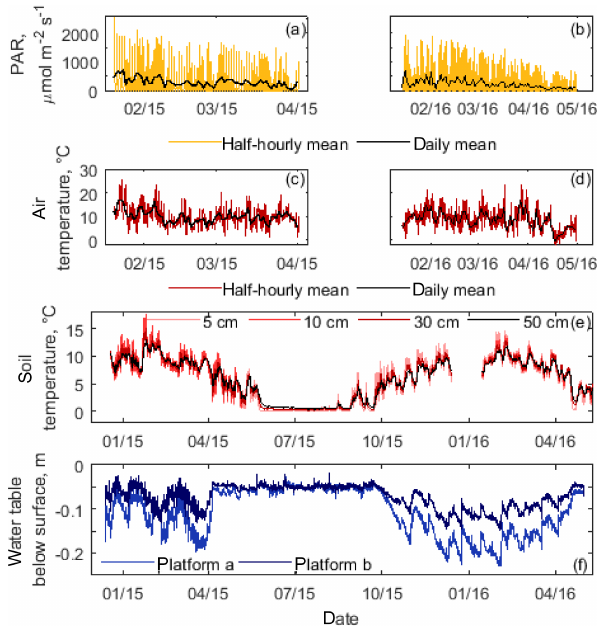
Figure 2. Time series of environmental variables during the study period. Photosynthetic active radiation (PAR, a, b ) and air temper- ature ( c, d ) are presented as half-hourly and daily means during two austral summer periods. Soil temperature ( e ) and water table position below the surface ( f ) were continuously recorded and are shown as half-hourly means. Note the difference in response time between platform a and platform b where water table fluctuations were